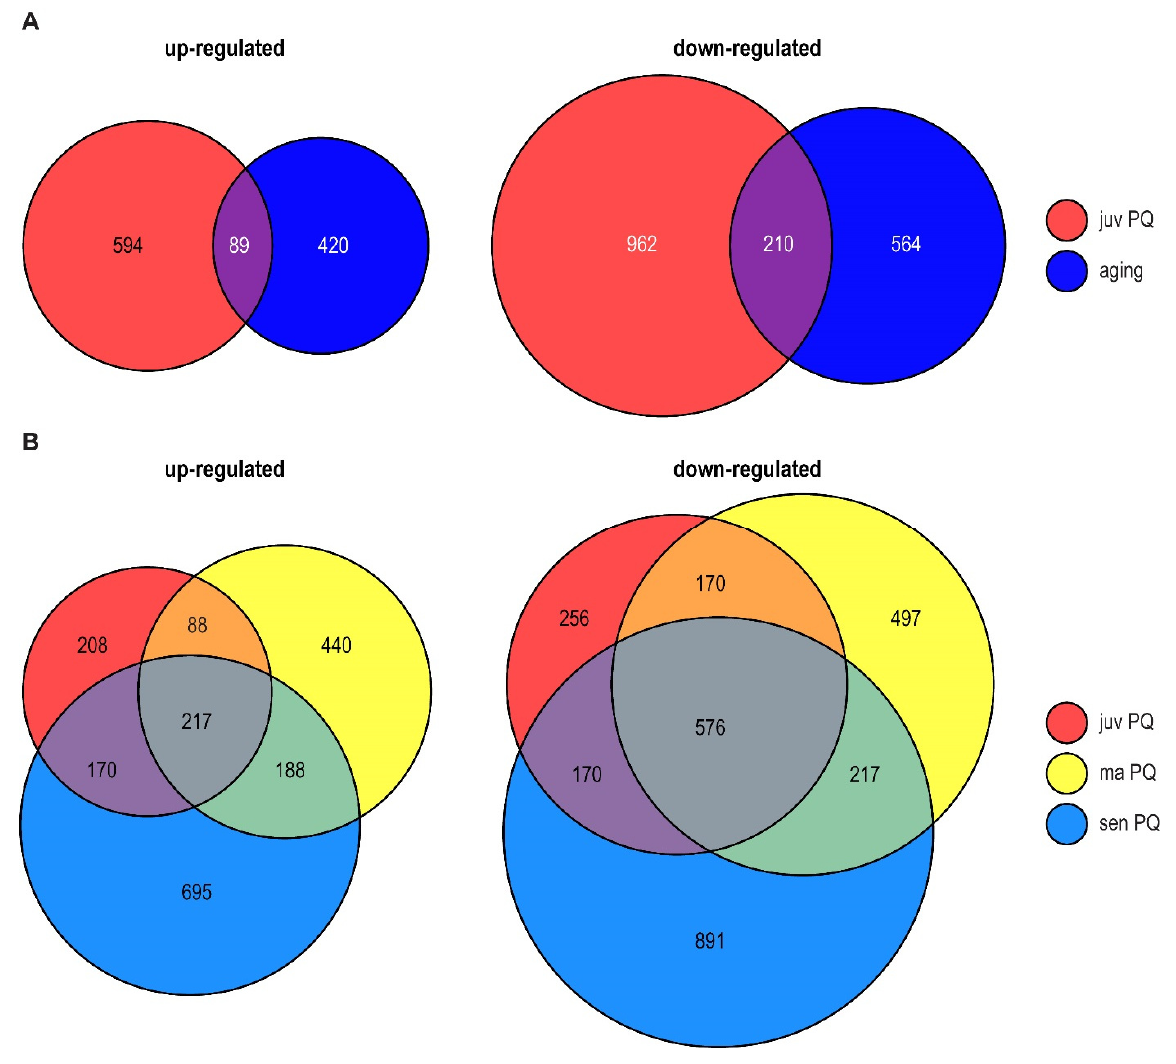
FIGURE 2: Differential transcript abundance during PQ-stress and aging. Venn diagrams of up- (left) and down- (right) regulated transcripts (factor 3; pV < 0.01) identified in transcriptome analysis. Factors are the quotient of tpm (tags per million) of treated (200 µM PQ for 24 h or aging) and control samples. (A) Venn diagram of transcripts regulated in juvenile PQ-treated (juv PQ = tpm 6 days PQ / tpm 6 days control, red) and aged cultures (tpm 14 days control/ tpm 6 days control, dark blue) and (B) juvenile PQ-treated (juv PQ = tpm 6 days PQ /tpm 6 days control, red), middle-aged PQ-treated (ma PQ = tpm 11 days PQ / tpm 11 days control, yellow) and senescent PQ-treated (sen PQ = 15 days PQ/ 14 days control, light blue) P. anserina . The size of a circle represents the number of regulated